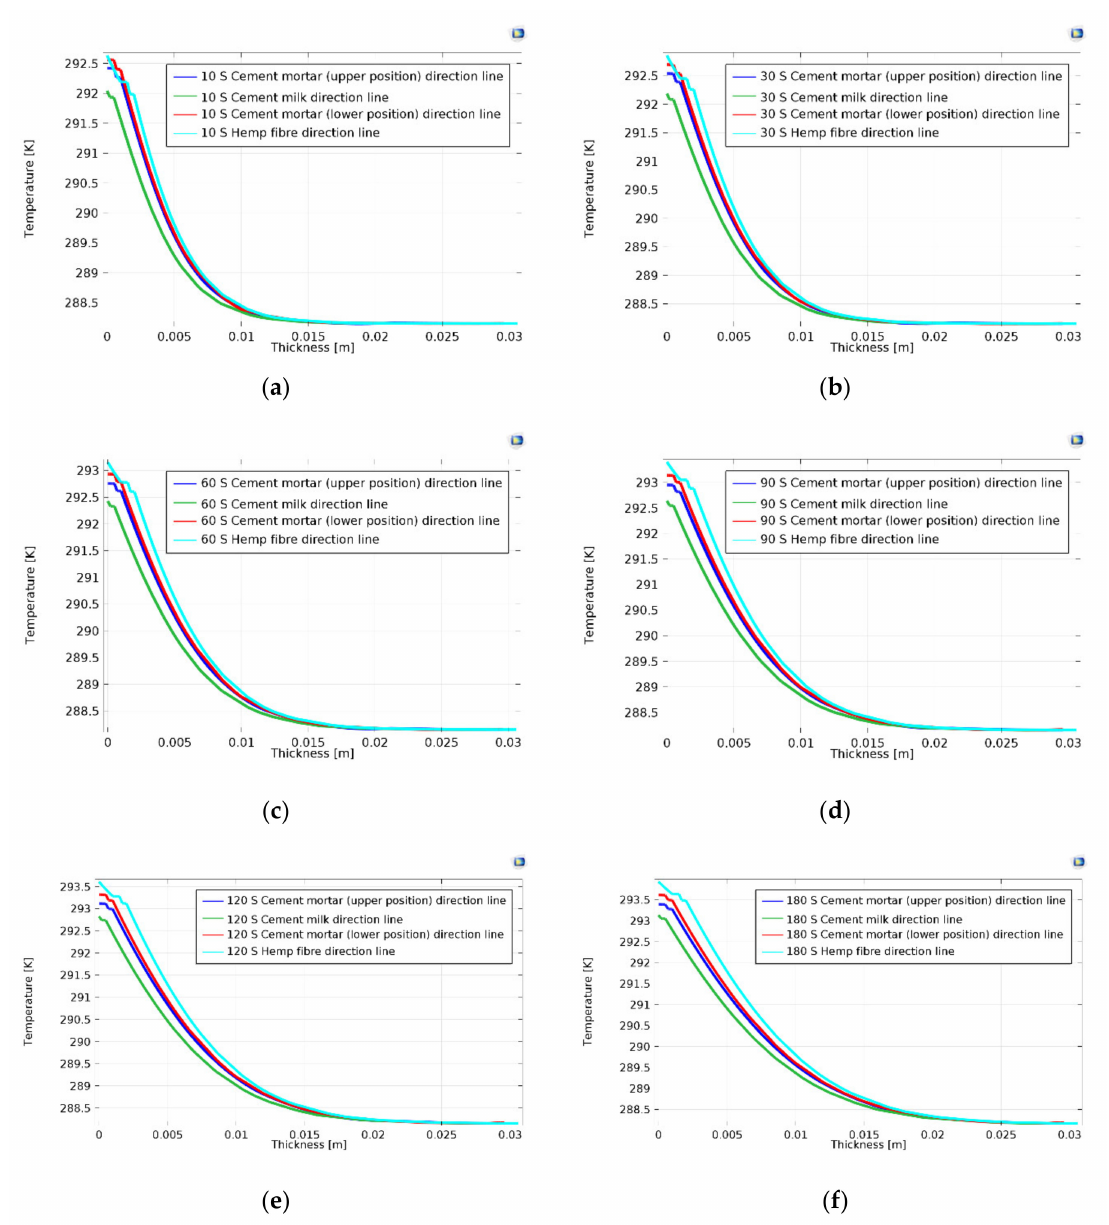
Figure 9. In-depth temperature profiles in the cooling phase (total time in brackets): ( a ) 10 s of cooling (70 s), ( b ) 30 s (90 s), ( c ) 60 s (120 s), ( d ) 90 s (150 s), ( e ) 120 s (180 s), ( f ) 180 s (240